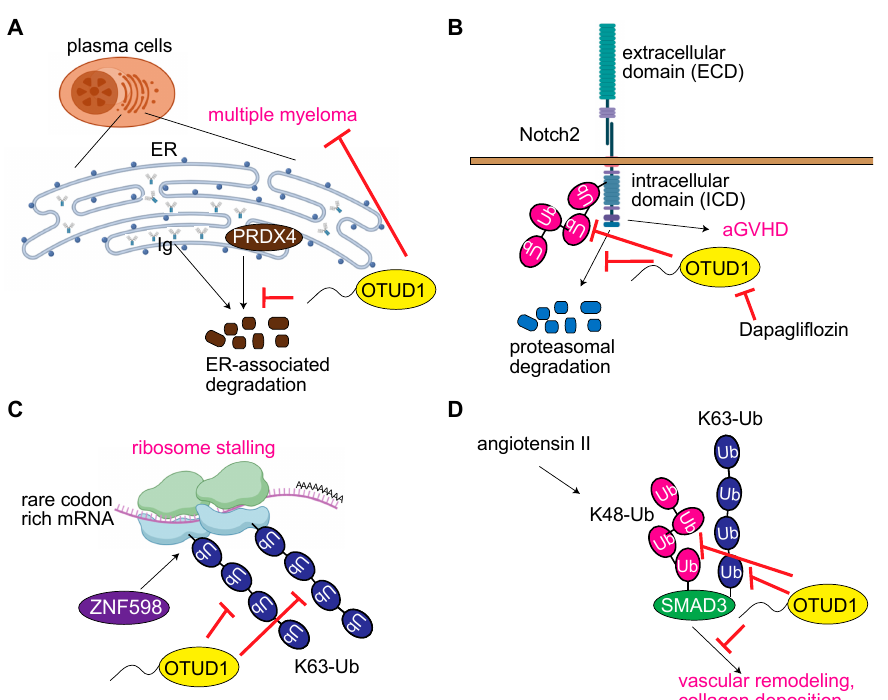
Figure 6. Extended cellular functions of OTUD1. ( A ) OTUD1 affects multiple myeloma through the regulation of ER-associated degradation of PRDX4 [51]. ( B ) OTUD1 is involved in aGVHD through the regulation of Notch2-ICD degradation, and dapagliflozin may be an inhibitor of OTUD1 [52]. ( C ) OTUD1 resolves stalled translation [56]. ( D ) OTUD1 promotes angiotensin-II-induced vascular remodeling by deubiquitinating SMAD3 [57].